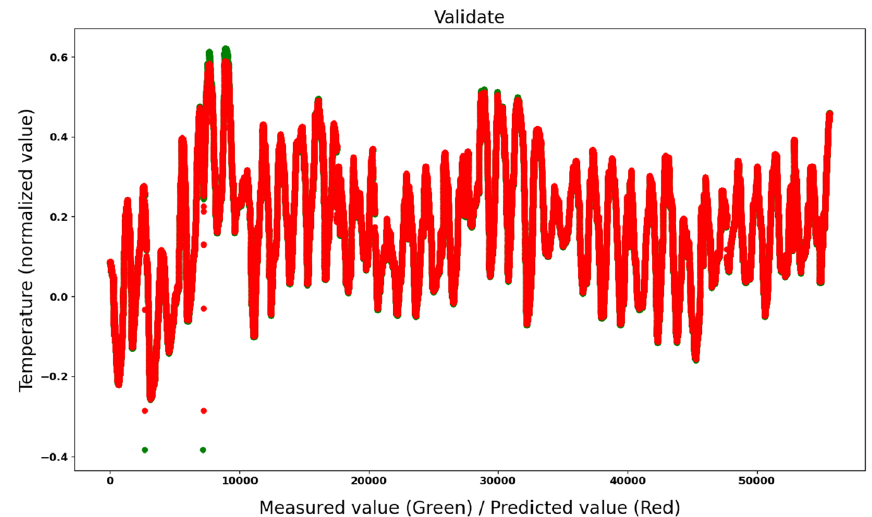
Fig. 10 Temperature prediction using the neural network fed by STSDaMaS